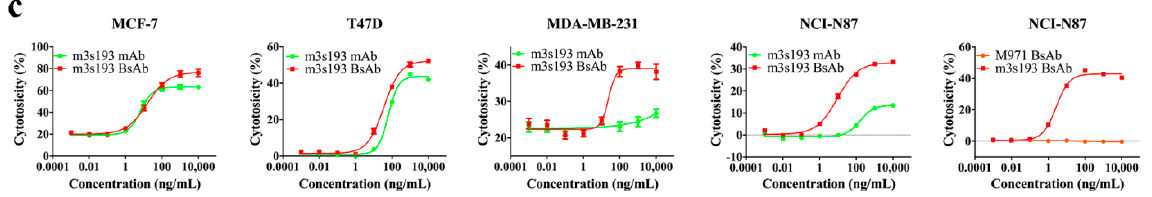
Figure 2. Flow cytometry binding analysis and in vitro cytotoxicity mediated by huPBMCs. ( a ) FACS histograms of Lewis Y